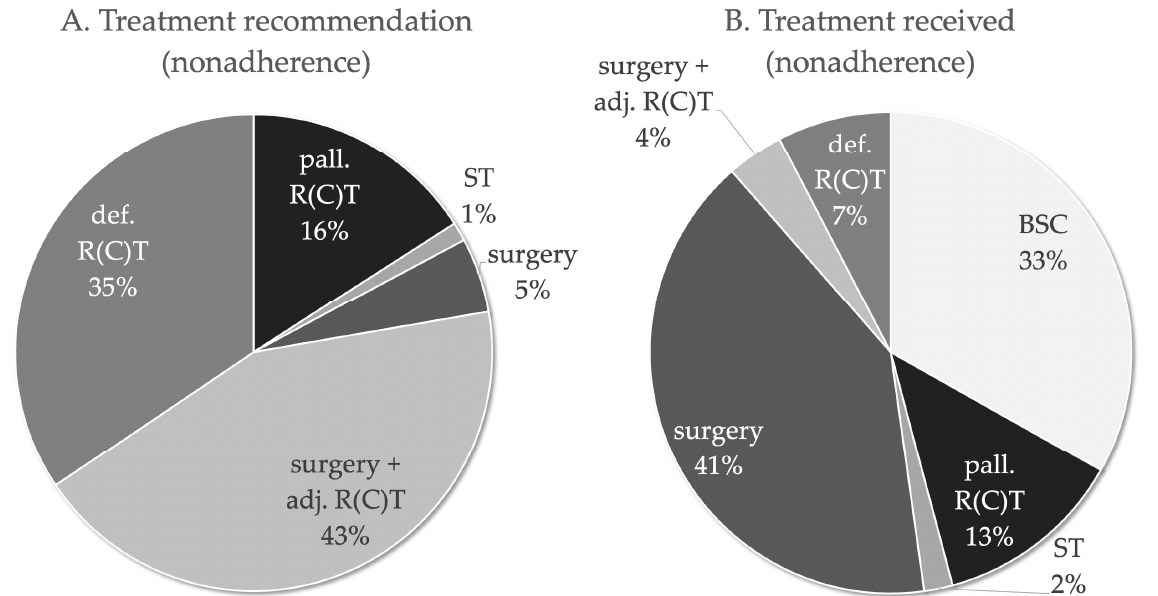
Figure 2. Treatment recommendations of the multidisciplinary tumour board of the nonadherent HNSCC patients ≥ 70 years. ( A ). Treatment recommended and ( B ). Treatment received by nonadherent patients.